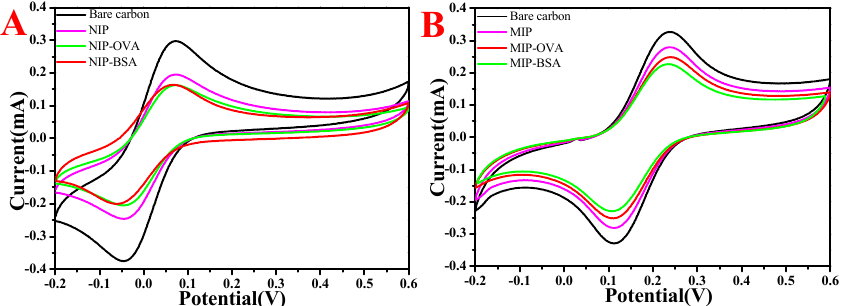
Figure 8. The cyclic voltammetry curves of MIP ( A ) and NIP ( B ) CaAlg membrane. NaAlg concentration: 2.5 wt.%; pH of BSA solution: 6.2; and pH of Tris-HCl: 7.4.